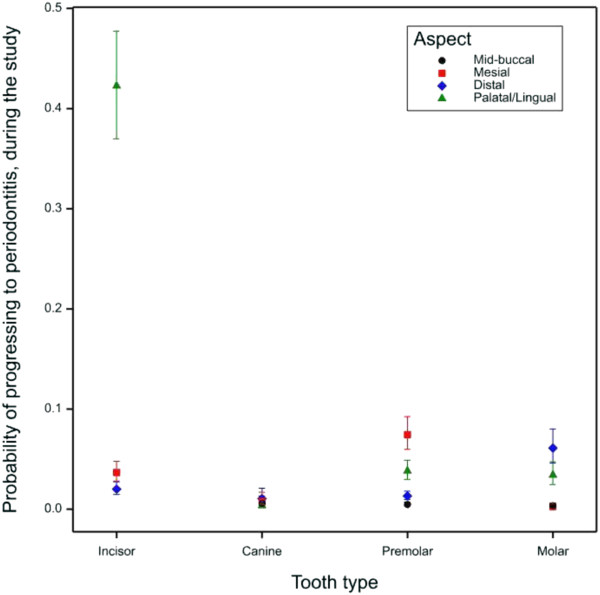
Probability of each aspect progressing to periodontitis. Error bars signify 95% confidence intervals.